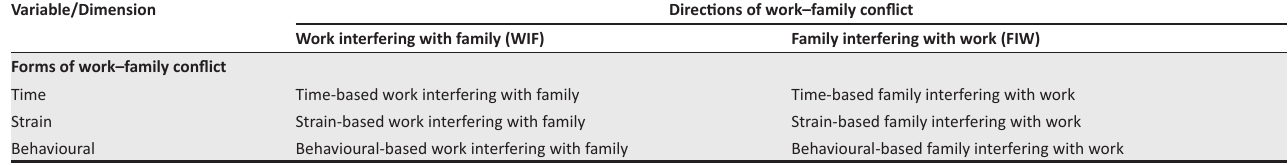
TABLE 1: Dimensions of work–family conflict.